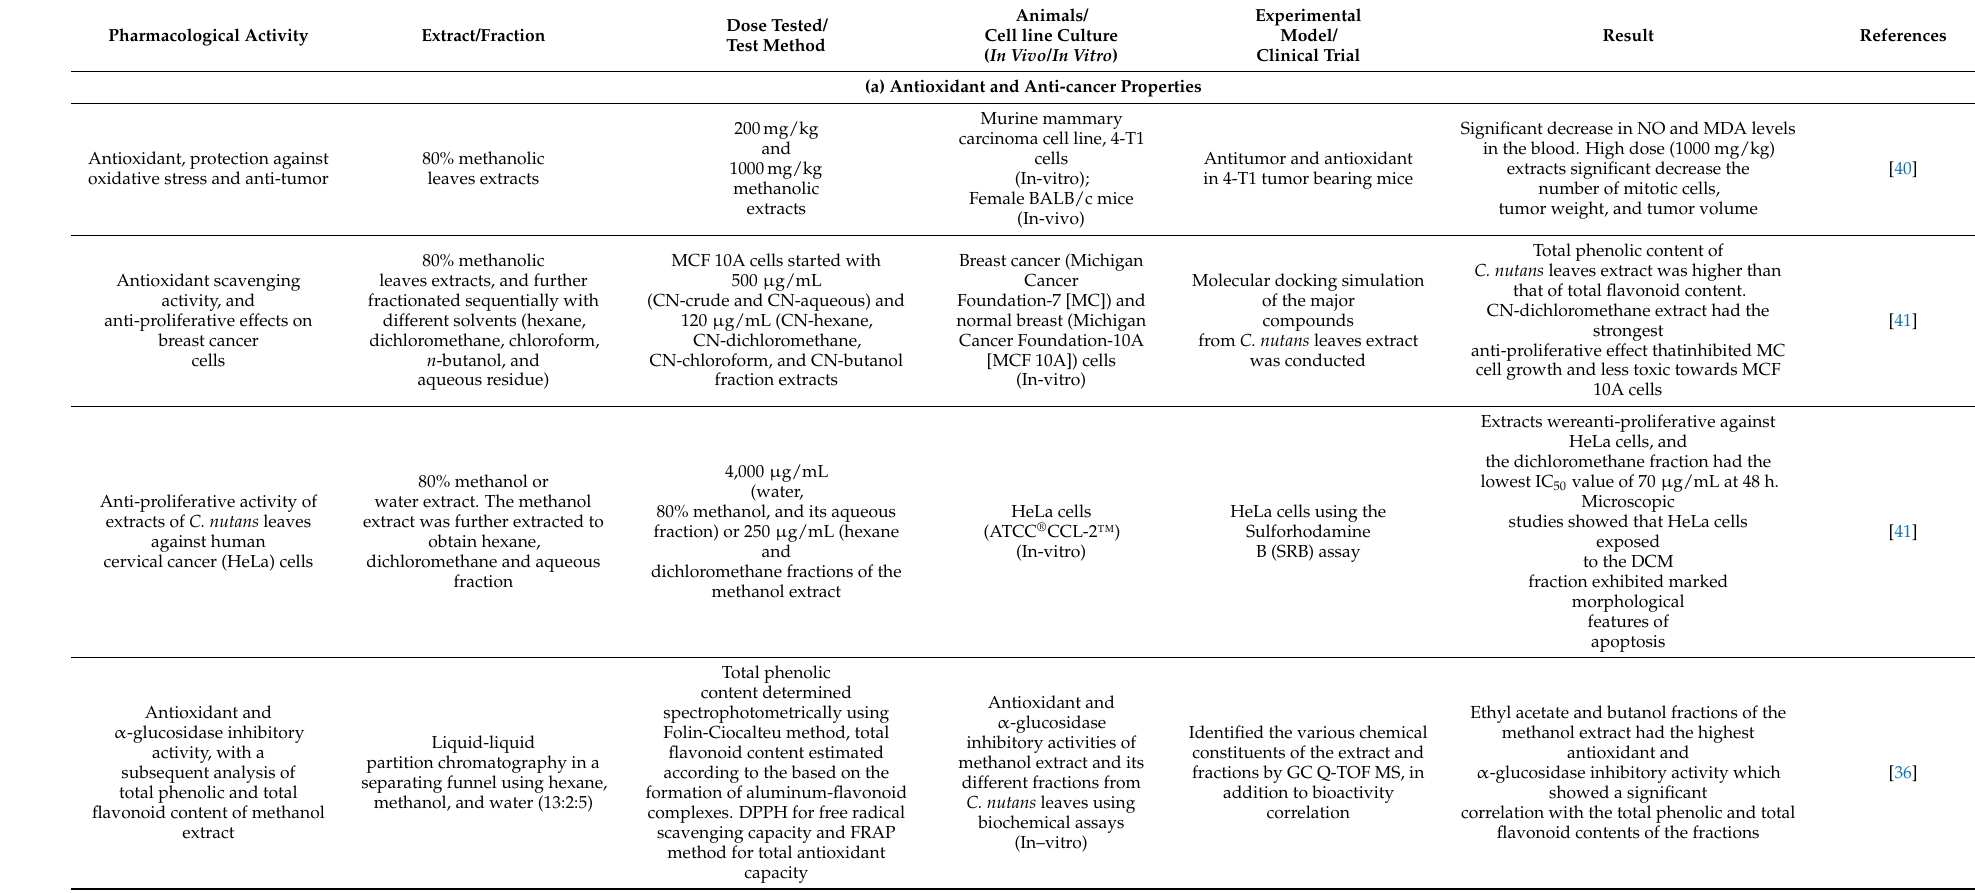
Table 6. Pharmacological effect of C. nutans